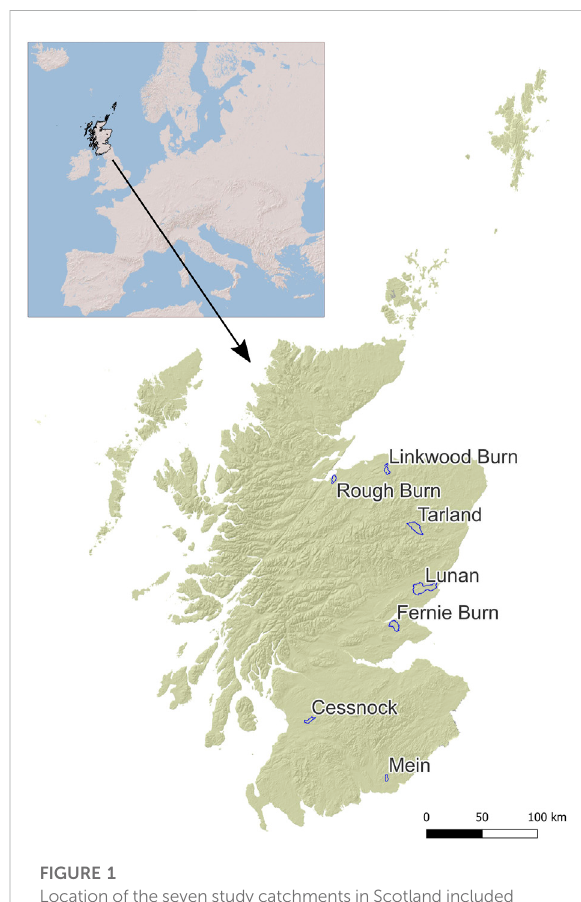
FIGURE 1 Location of the seven study catchments in Scotland included in model development and